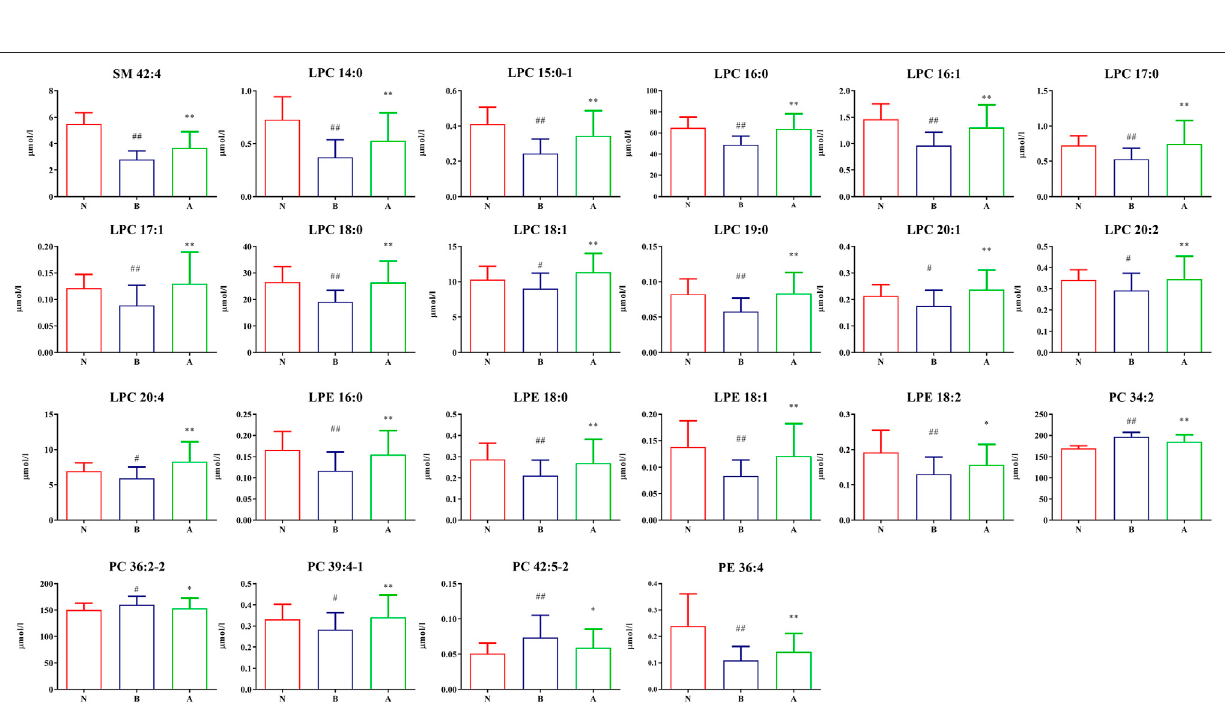
Frontiers in Pharmacology |